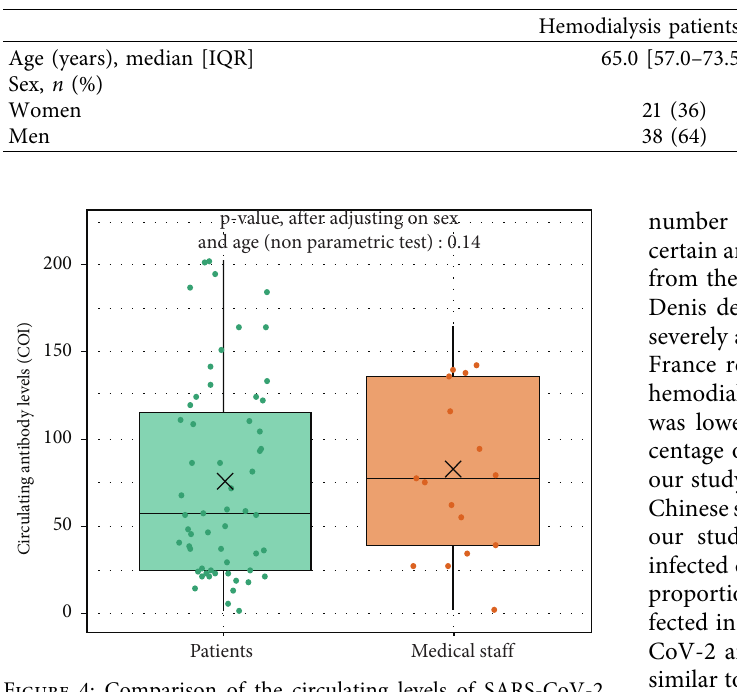
Table 3: Characteristics of the hemodialysis patients ( N � 59) and the control group without kidney disease ( N � 17).